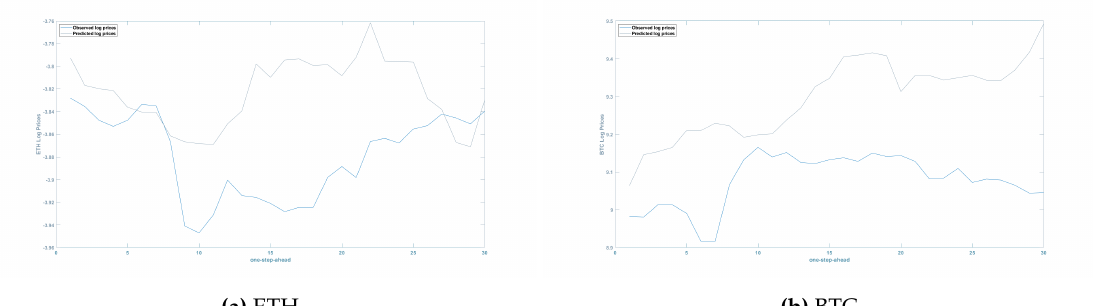
Figure 6. Mean posterior out-of-sample predictions (gray line) for L = 30 days both for the ( a ) ETH and ( b ) BTC log-transformed price series (blue line). While the predictions for ETH are better than those for BTC, both are not satisfactory as they frequently miss the direction of price movement. The BTC predictions are essentially the same for both the 2016–2019 and 2013–2019 data sets (the second not shown